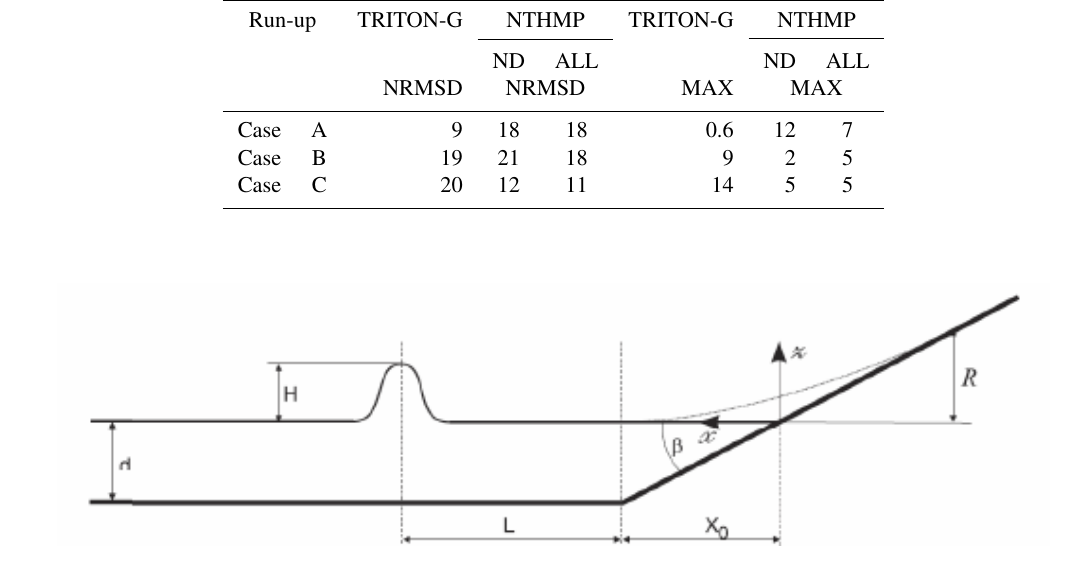
Figure A1. Domain sketch for BP4, slope 1 : 19 . 85 (figure taken from benchmark